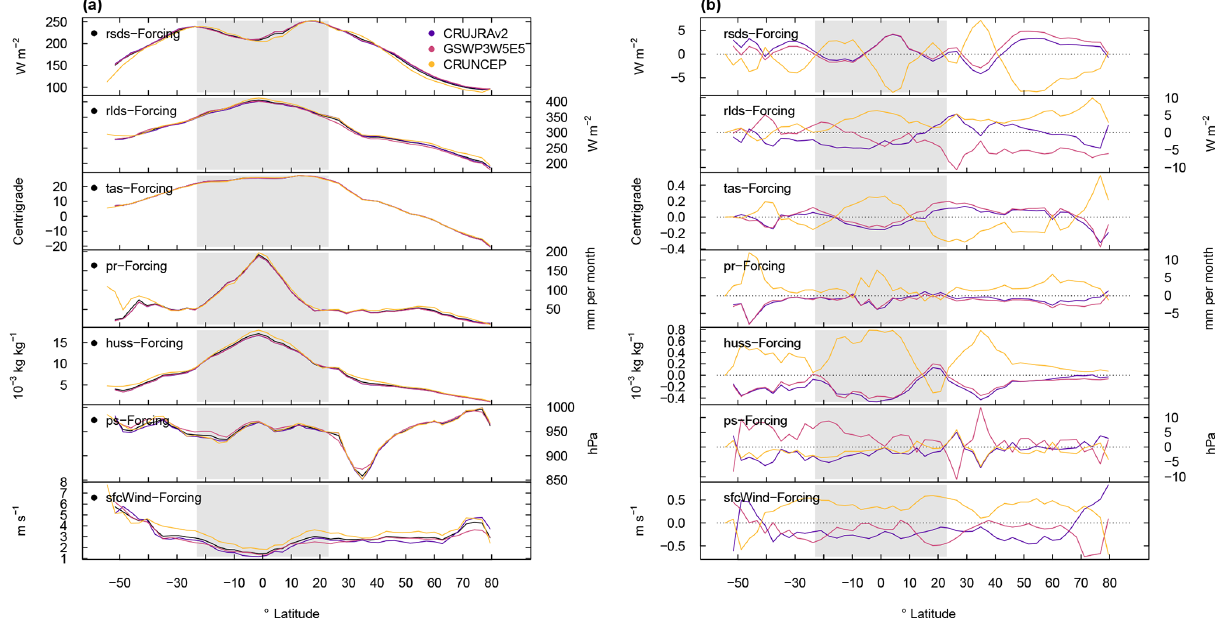
Figure A1. (a) Zonal mean values of meteorological forcing data and (b) corresponding difference between the individual forcing and the mean of the three forcings, where rsds and rlds are the surface downwelling SW and LW radiation, respectively, tas is the near-surface air temperature, pr is the precipitation, huss is the near-surface specific humidity, ps is the surface pressure, and sfcWind is the near-surface wind